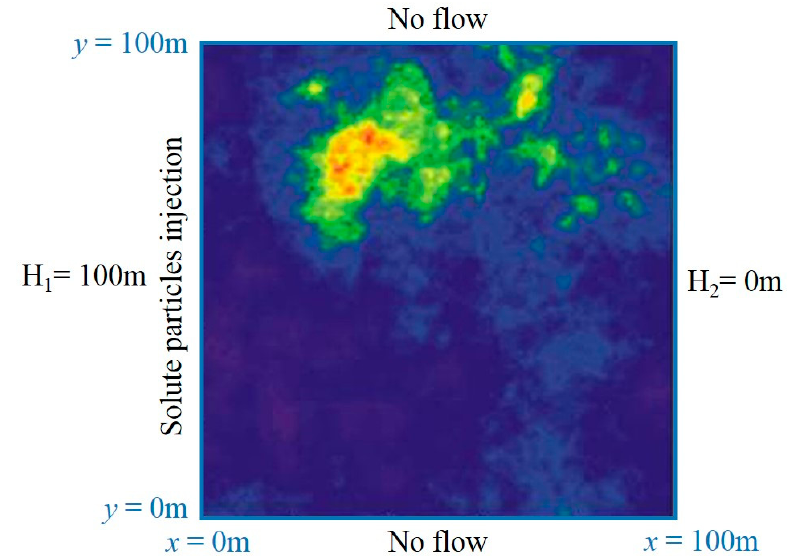
Figure 5. Square-typed single fracture and boundary conditions used in this study.